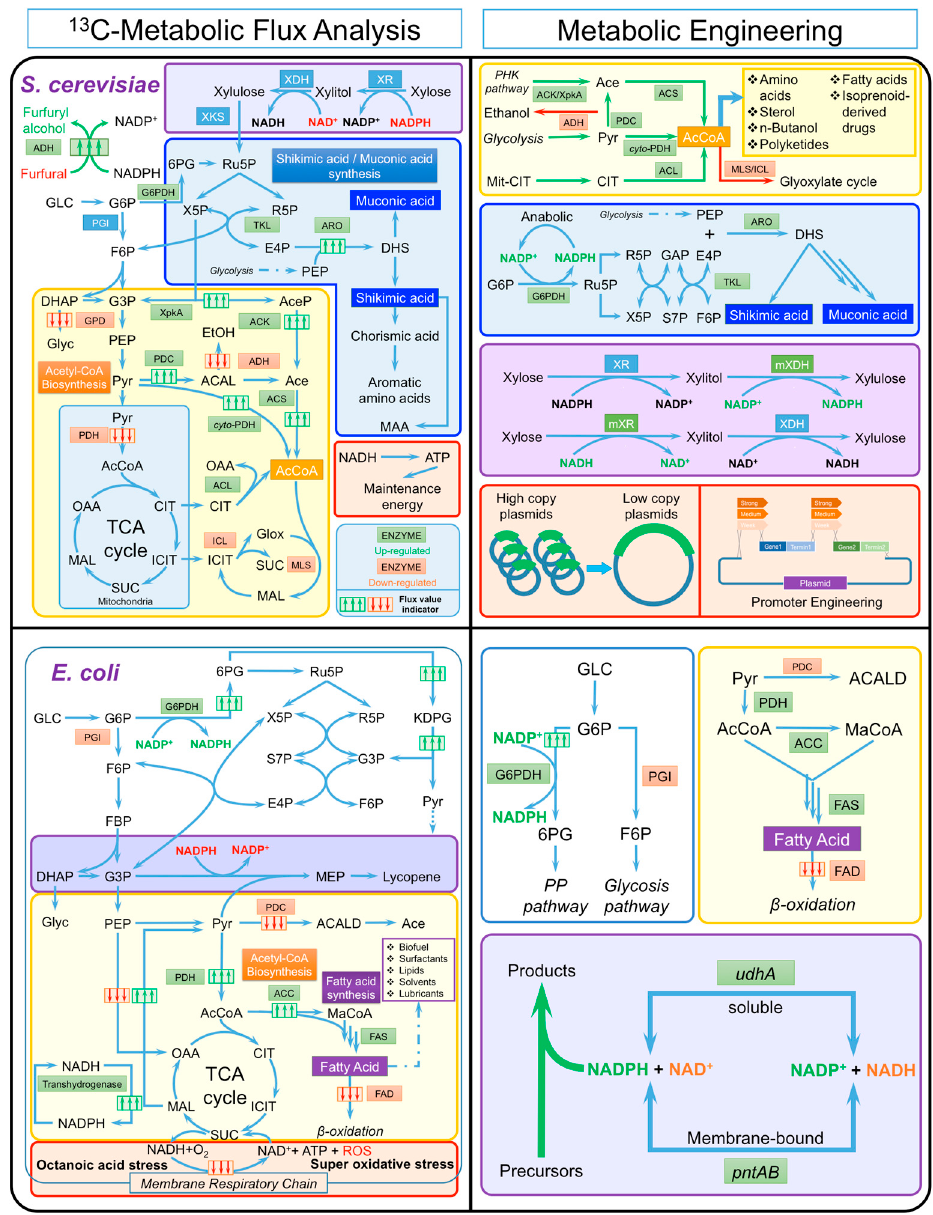
Figure 3. Integration of the major discoveries from 13 C-MFA and corresponding metabolic engineering strategies for S. cerevisiae and E. coli . Abbreviations: G6P: Glucose 6-Phosphate, F6P: Fructose 6-phosphate, 6PG: 6-Phosphogluconate, Ru5P: Ribulose 5-Phosphate, X5P: Xylulose 5-phosphate, R5P: Ribose 5-Phosphate, E4P: Erythrose 4-Phosphate, PEP: Phosphoenolpyruvate, SA: Shikimic acid, MA: Muconic acid, MAA: Mycosporine-like Amino Acids, AA: Amino Acids. PGI: Phosphoglucose isomerase, G6PDH: G6P dehydrogenase, TKL: Transketolase, ARO: Pentafunctional protein ARO1p. DHAP: Dihydroxyacetone phosphate, G3P: Glyceraldehyde 3-phosphate, Glyc: Glycerol, AceP: Acetyl-P, EtOH: Ethanol, Pyr: Pyruvate, ACAL: Acetaldehyde, Ace: Acetate, AcCoA: Acetyl-CoA, OAA: Oxaloacetate, CIT: Citrate, ICIT: Isocitrate, SUC: Succinate, MAL: Malate, Glox: Glyoxylate, GPD: Glycerol-3-phosphate dehydrogenase. XpkA: Phosphoketolase, ACK: acetate kinase, PDC: Pyruvate Decarboxylase, ADH: Alcohol dehydrogenase, PDH: Pyruvate dehydrogenase, cyto-PDH: Cytosolic pyruvate dehydrogenase, ACS: Acetyl-CoA synthetase, ACL: ATP citrate lyase, ICL: Isocitrate lyase, MLS: Malate synthetase. MaCoA: Malonyl-CoA, ACC: Acetyl-CoA carboxylase, FAS: Fatty acid synthesis enzymes, FAD: Fatty acids degradation enzymes, MEP: 2-methylerythritol 4-phosphate, mXR: Mutated xylose reductase, mXDH: Mutated xylitol dehydrogenase.